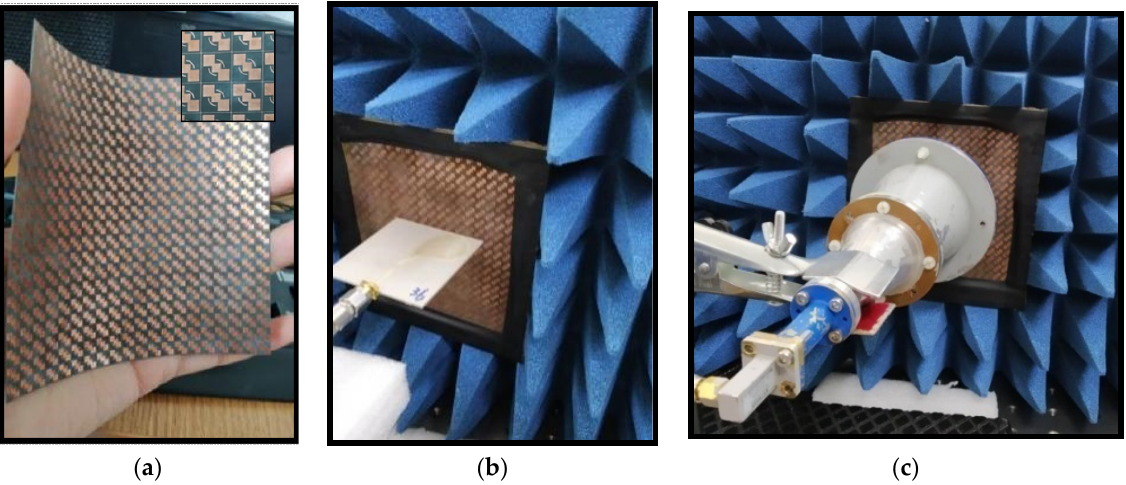
Table 2. Performance comparison with other state-of-the-art dual-band polarization converters (LC- to-CPs) .